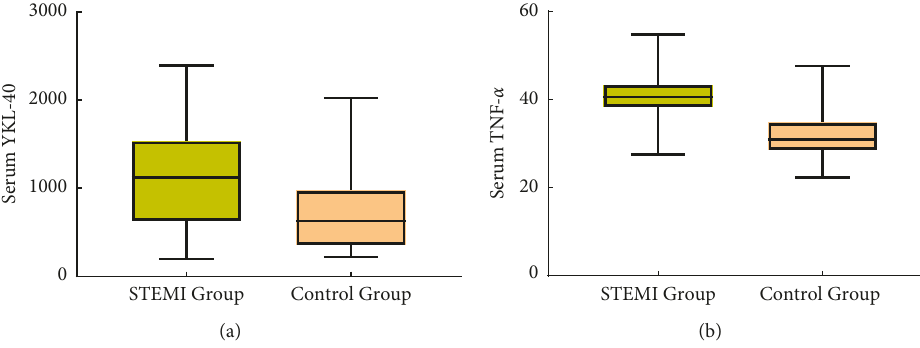
Figure 1: Data distribution of serum YKL-40 and TNF- α in two groups.